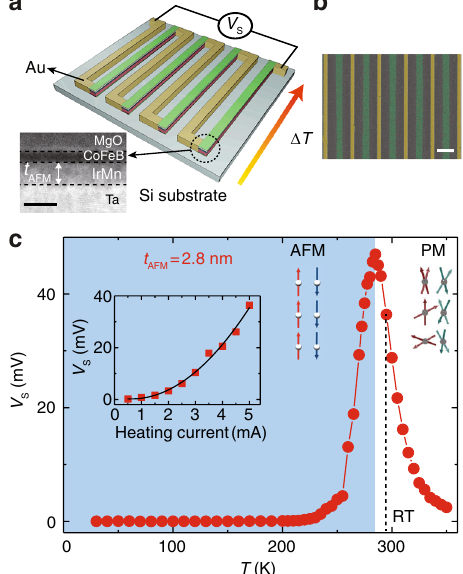
Fig. 2 Temperature-dependent Seebeck effect measured on a meandering thermopile. a An illustrative diagram of the thermopile consisting of periodic IrMn-based thin fi lm bars connected in series with gold leads. The temperature difference Δ T is applied in-plane by a Joule heater (Supplementary Note 6 and Supplementary Fig. 5). The inset shows a high angle annular dark fi eld scanning transmission electron microscopy (HAADF STEM) image of the IrMn-based magnetic multilayer, where t AFM is the IrMn layer thickness. The black scale bar is 5 nm. b A color-coded scanning electron microscope (SEM) image of the meandering thermopile. The green and yellow bars are the 800nm wide IrMn-based thin fi lms and the 400nm wide gold leads. The white scale bar is 2 µ m. c The Seebeck voltage measured on the sample with IrMn thickness t AFM = 2.8 nm, from 10 to 350 K. The antiferromagnetic (AFM) phase in light blue and paramagnetic (PM) phase in white are divided by a critical temperature T ≈ 285 K. The dashed line indicates room temperature. Inset shows the crit Seebeck voltage measured at RT as a function of the heating current up to 5 mA. Red squares are measured data. The black line shows a quadratic fi t to the data.